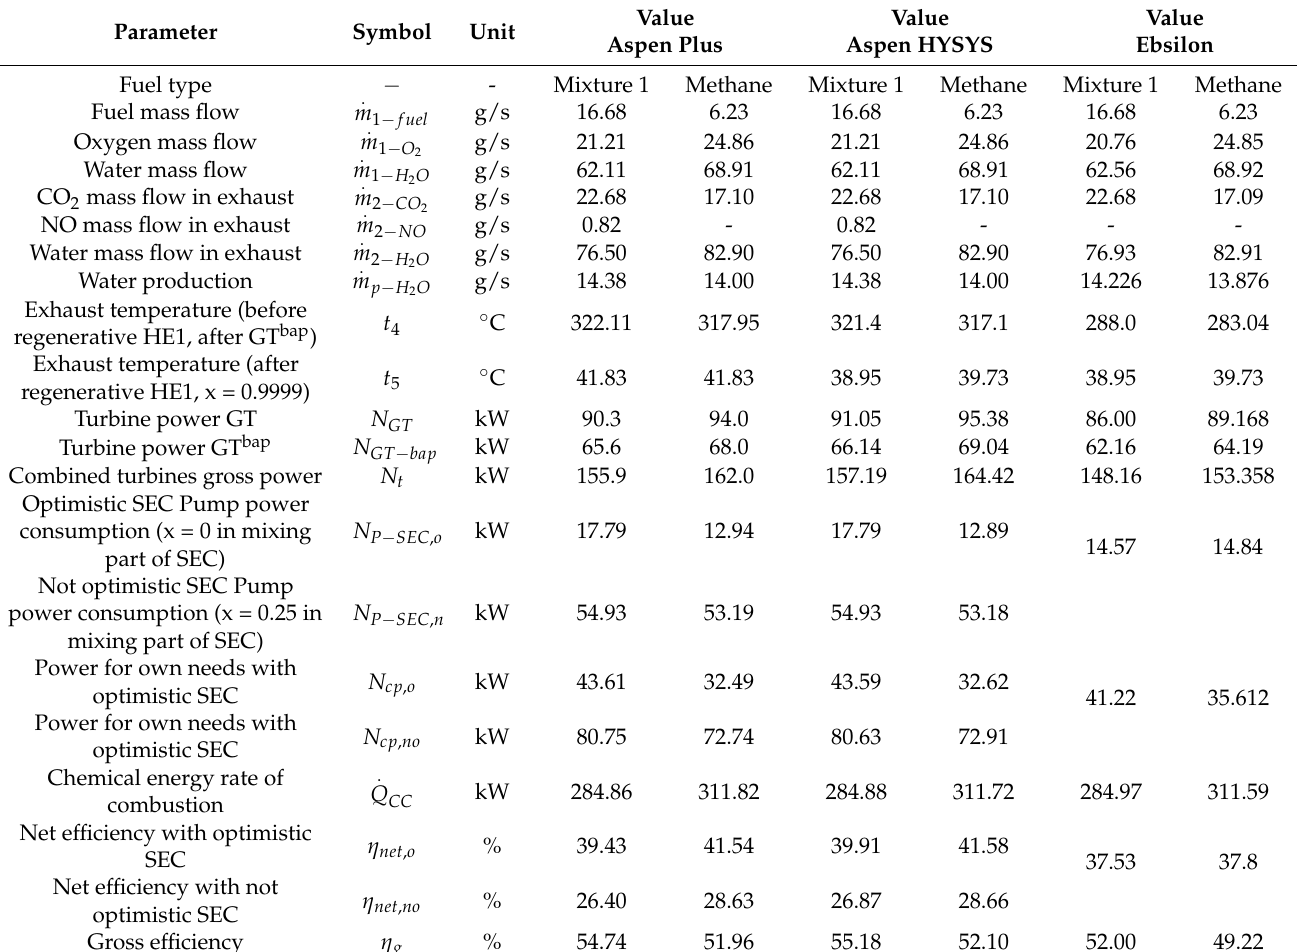
Table 12. Results for mixture 1 and methane—“PFD1”—summary